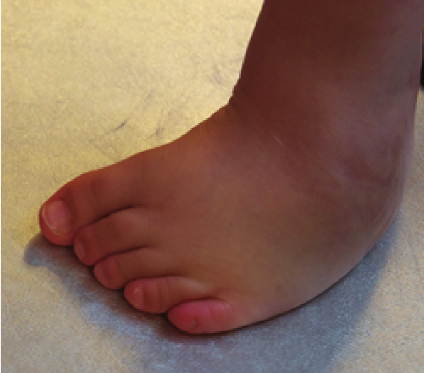
Figure 4: Clubfoot status after revision surgery with recurrent deformity, anterior